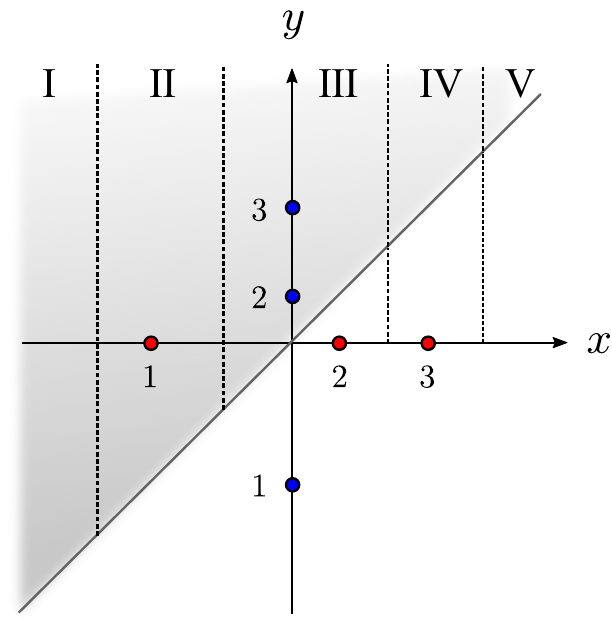
Figure 9: Integration domain of the bilocal operator. The shaded part is the domain for x < y